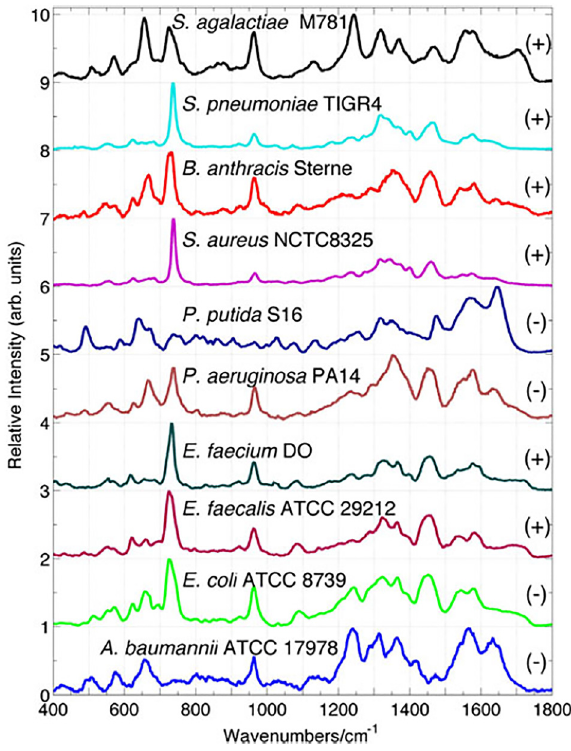
Figure 5: Surface-enhanced Raman spectroscopy (SERS) spectra of 10 bacterial species excited at 785 nm on Au NP substrates. The spectraareaveragesoffourtosixindividualspectraandnormalized to the intensity of the strongest feature in each spectrum. Gram- positive (plus sign) and gram-negative (minus sign) types are indi- cated. Reprinted with permission from Premasiri et al. [55]: Springer Nature, Copyright